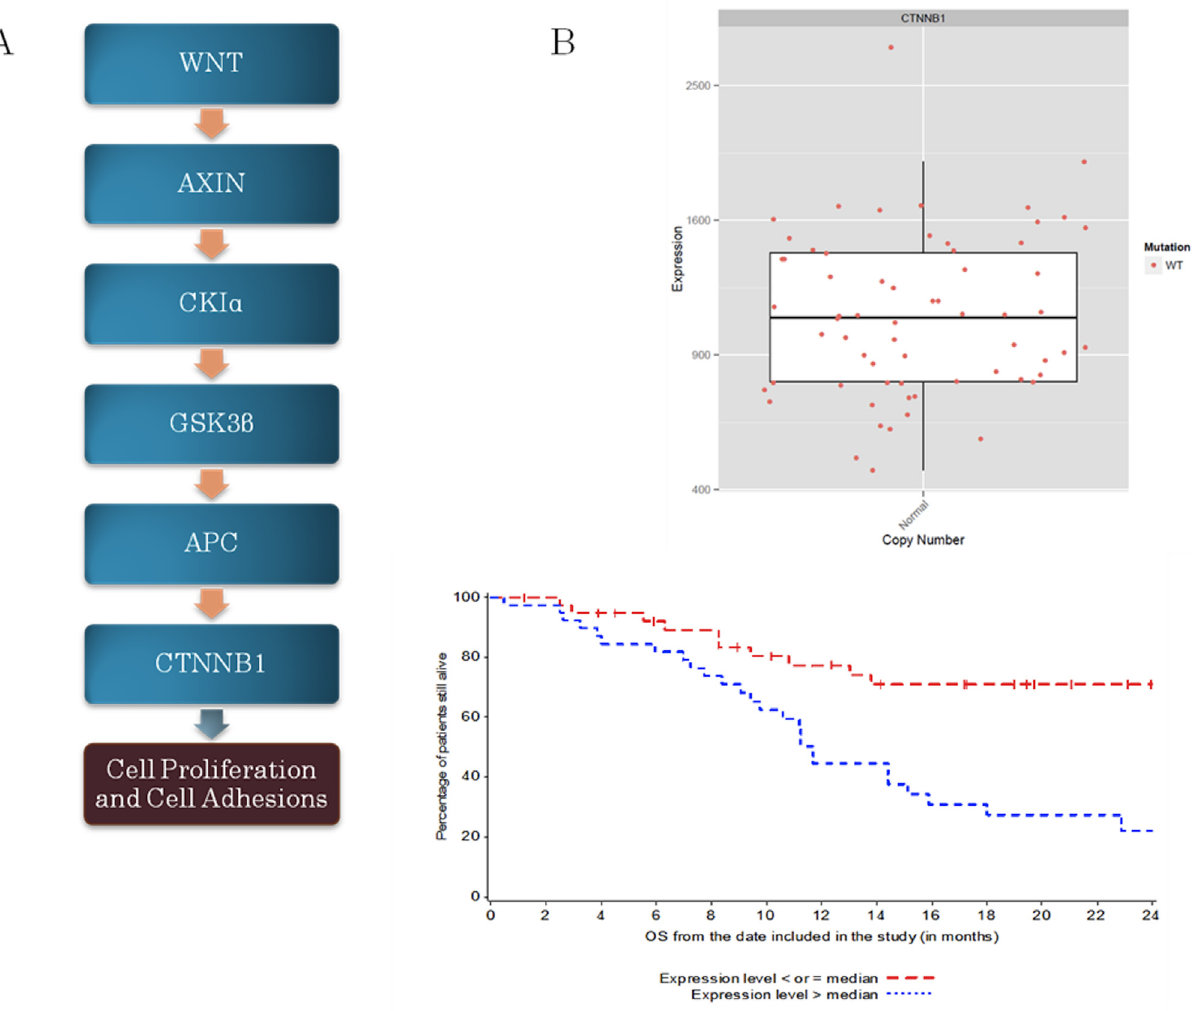
Fig 2. A: WNT/CTNNB1 pathway; B: Association between CTNNB1 overexpression and OS.